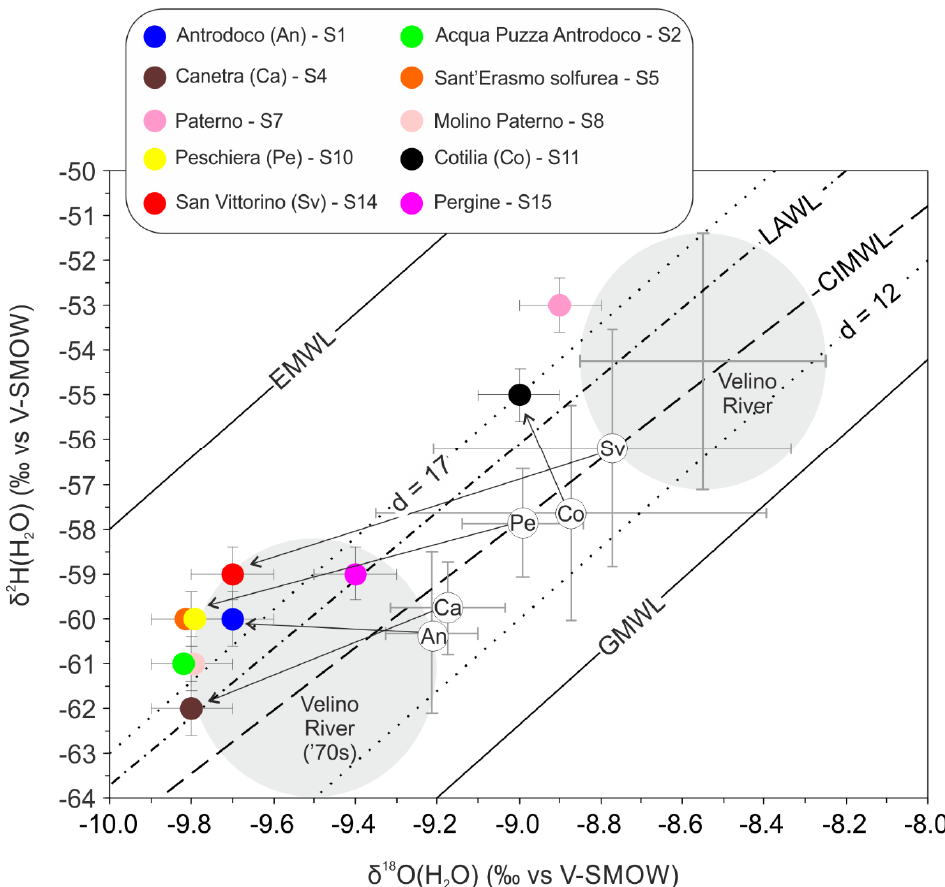
Figure 7. δ 2 H- δ 18 O (H 2 O) isotope values of some samples from the San Vittorino Plain. The global and Mediterranean meteoric water lines, with excess deuterium equal to d = 10 (GMWL) [113] and d = 22 (MMWL), respectively, are used. The central Italy meteoric water line (CIMWL) [120] and the central Italy limestone aquifer water line (LAWL) [121] are also displayed within the ribbon with extreme lines of d = 12 and d = 17. Historical analyses of the isotope composition of the Velino River fall within the deuterium excess variation range of the water lines. Similarly, the groundwater of the San Vittorino Plain also falls within the compositional variation range of local rainwater. The white circles with the abbreviations Ca, An, Pe, Co, and Sv are historical data of springs with the largest standard deviation variations on historical data. See Figure 1 for spring location.